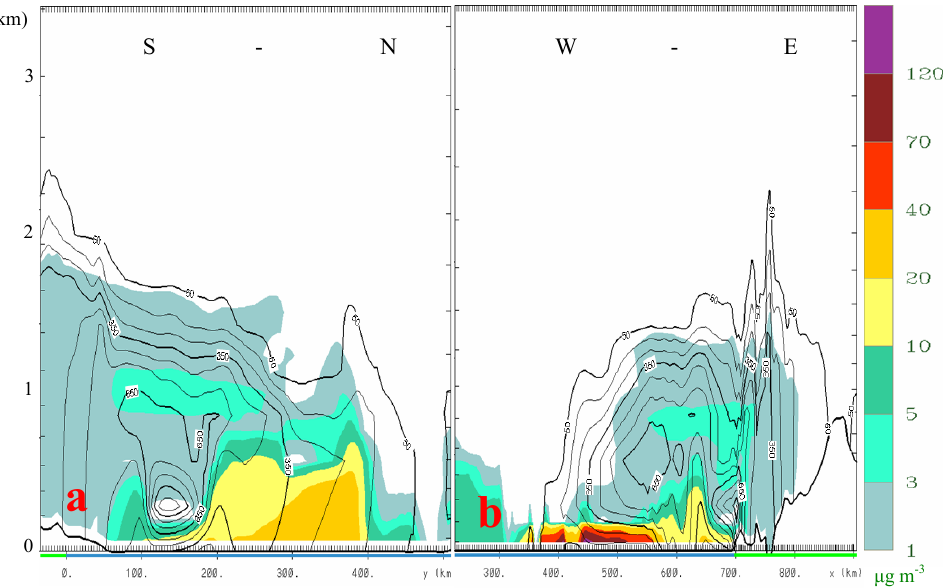
Fig. 8. (a) Vertical cross sections of dust concentration (black line contours in µgm − 3 ) and (b) sea salt concentration (color palette in µgm − 3 )